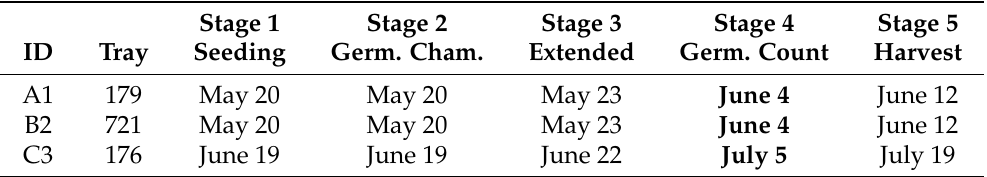
Table 1. Cultivation process stages. Stage 1: Seedling; stage 2: Storage in germination chamber; stage 3: Tray extended; stage 4: Germination day count; stage 5: Harvesting.